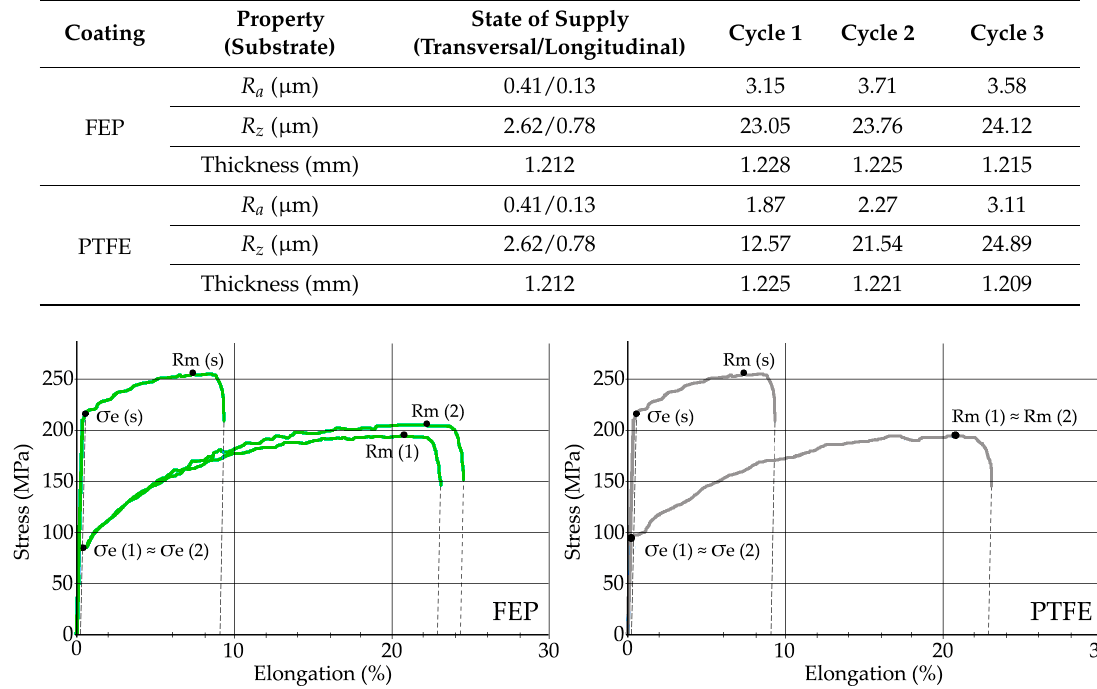
Table 5. Roughness and thickness of the substrate after each coating removal/application cycle.